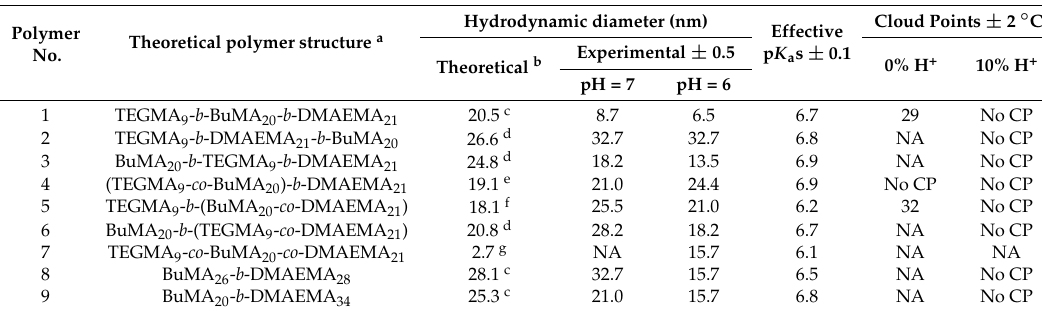
Table 2. Theoretical and experimental hydrodynamic diameters, effective p K a s and cloud points of 1% w / w aqueous copolymer